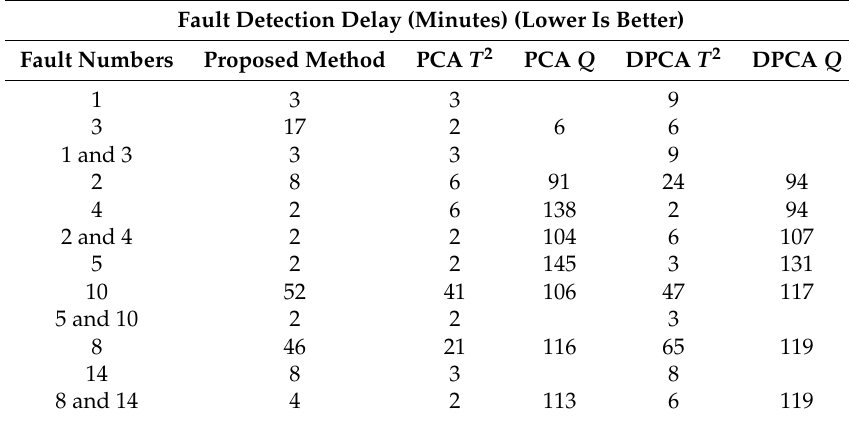
Table 2. Fault detection delay for the Tennessee Eastman